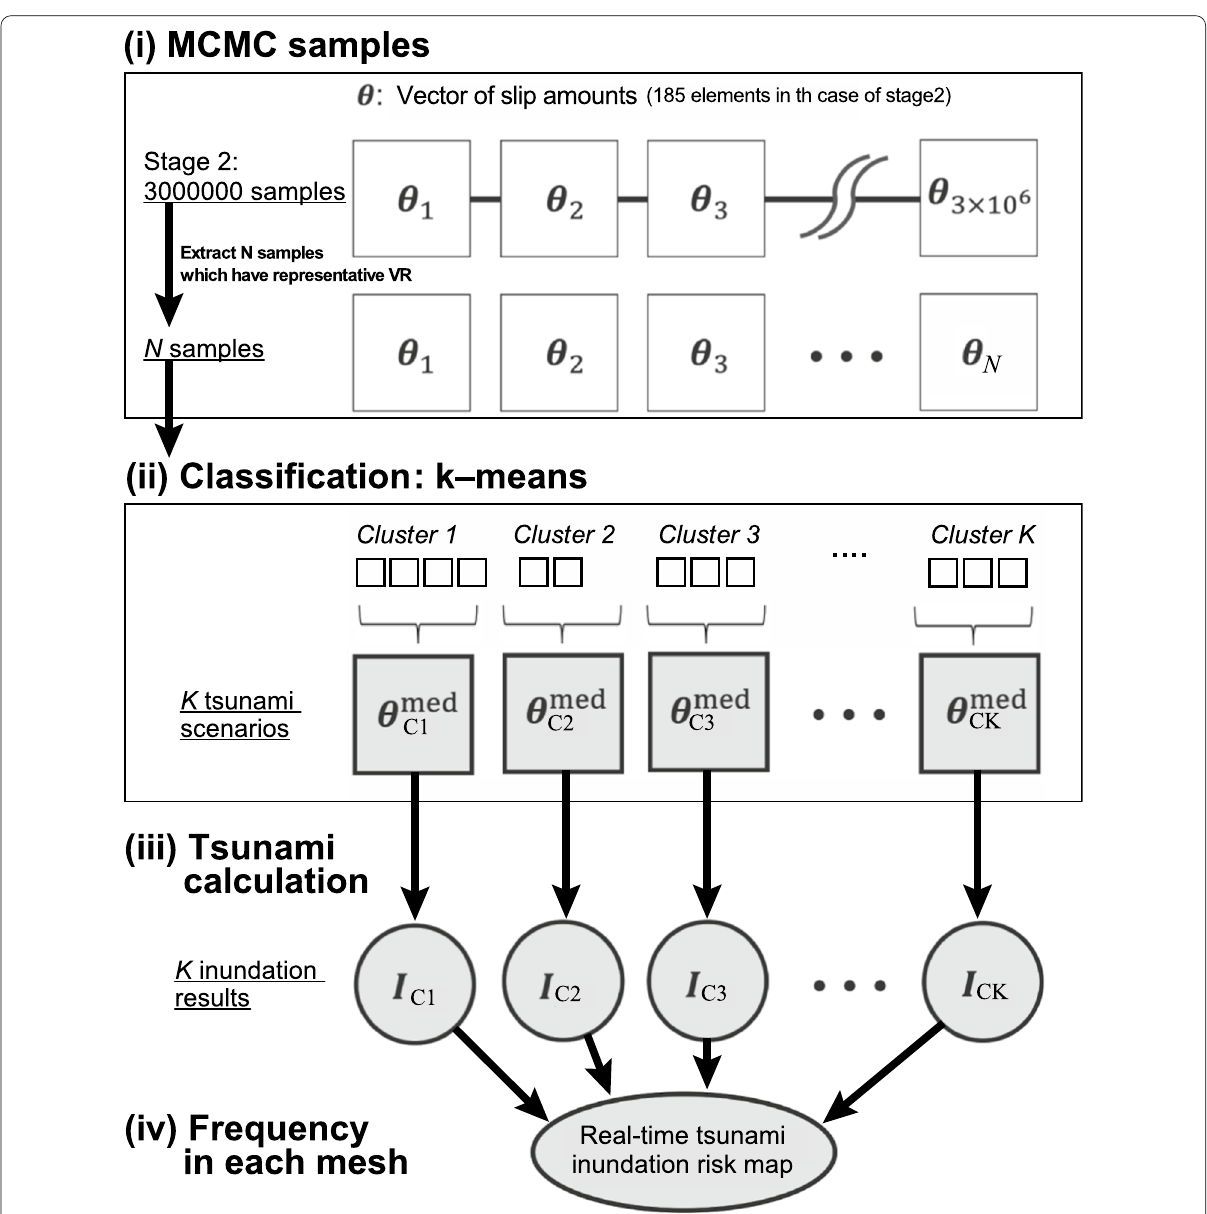
Fig. 3 Overview of the “real-time tsunami inundation risk map” process in the case of using MCMC samples in stage 2. (i) Obtain enough Markov chain Monte Carlo (MCMC) samples to evaluate the uncertainty of the slip distribution model ("Stepwise partitioning algorithm" section). Then, extract the samples in which variance reduction (VR) is equivalent to the representative value based on the posterior probability density function (PDF). (ii) Classify them into small clusters (K) by the k-means approach using θ as the feature value. (iii) Generate K representative slip distributions (using the median value in each subfault), and using them as inputs, calculate K individual tsunami inundations. (iv) Count the number of inundations on the